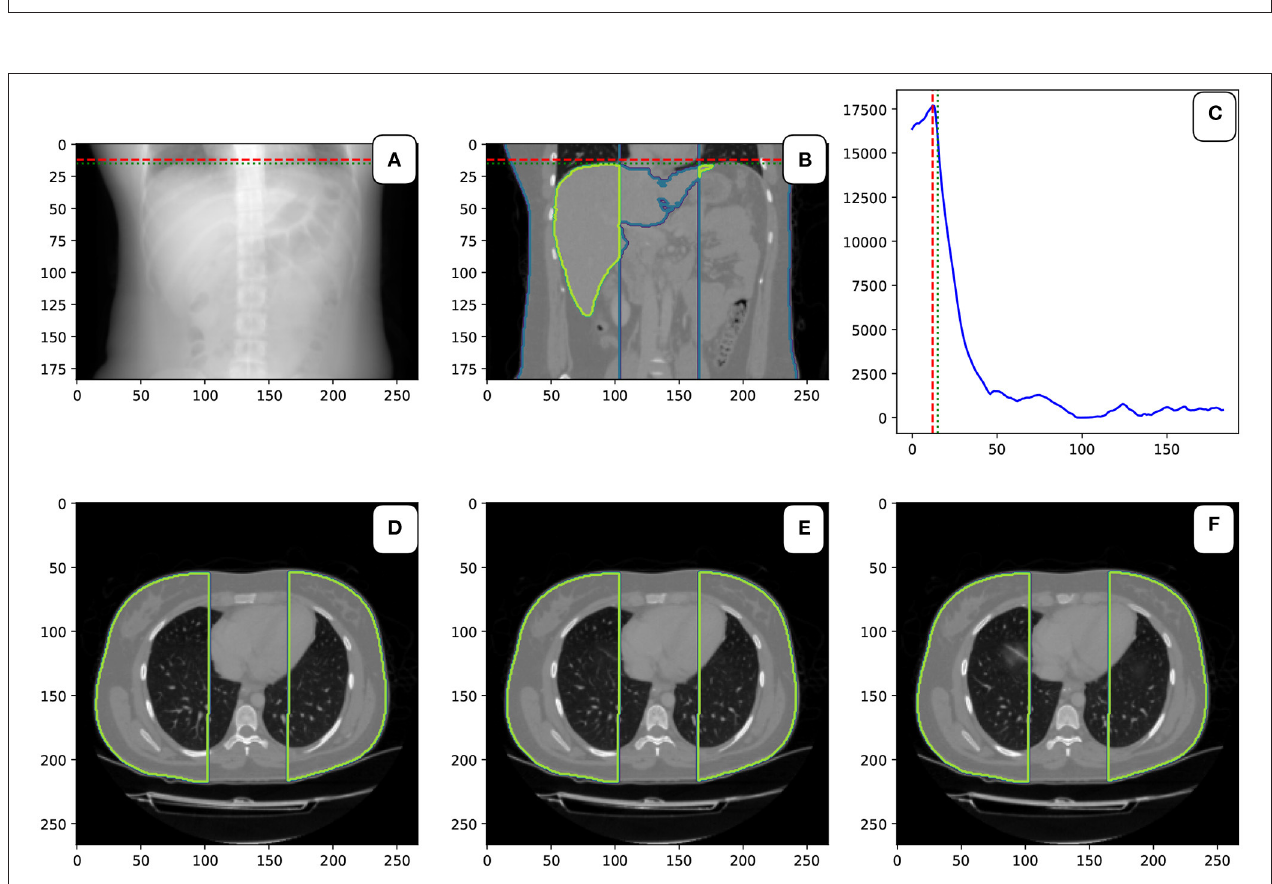
FIGURE 3 | Intensity features and position features based on robustly segmentable structures: The axial view on the middle slice of the CT scan can be found in the top row, while the coronal view is in the second row. The first column is the intensity image. The other columns show the Signed Distance Field (SDF) to the sagittal plane, coronal plane, the axial plane on the bottom level of the heart, and the body surface. The zero level of the SDF is red. The border of the liver is green.